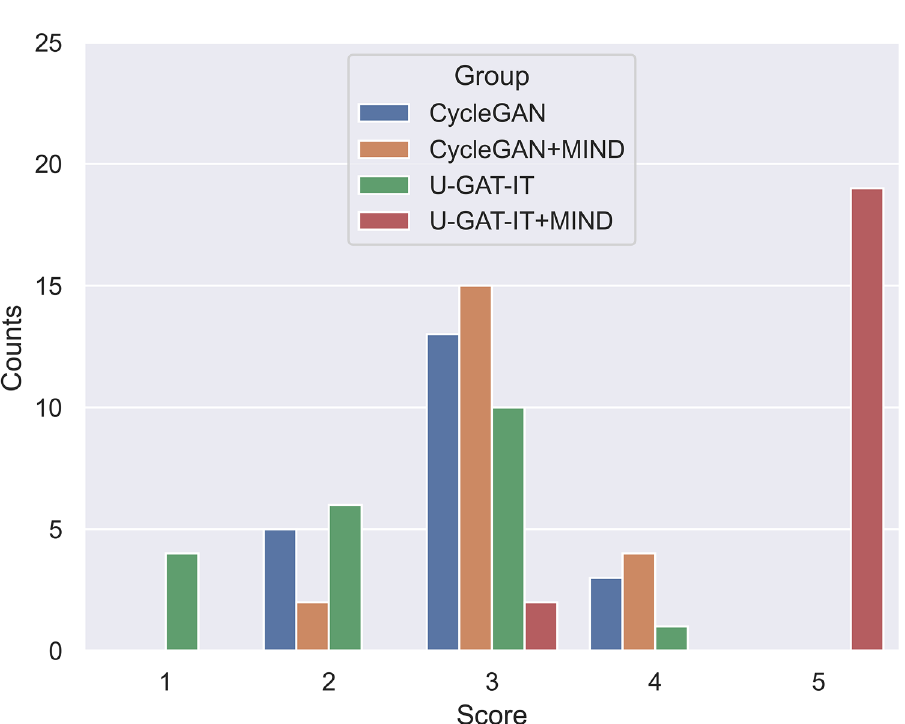
Figure 8. Distribution of evaluation scores for four groups by Dr.